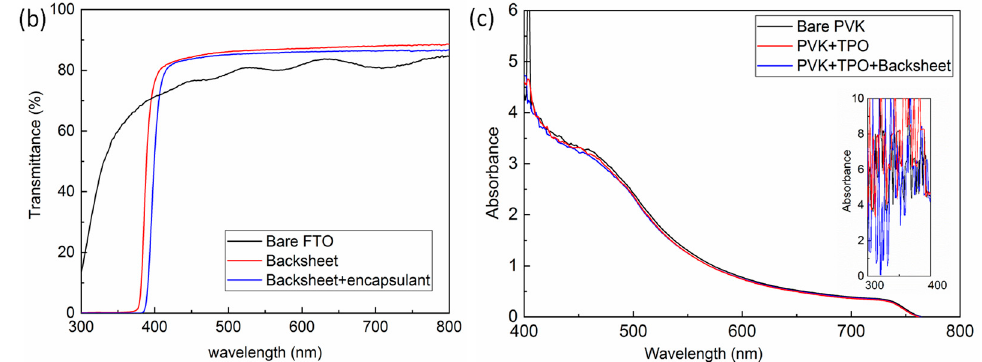
Figure 2. ( a ) J-V curve of the PSCs before and after encapsulation with different materials. ( b ) The transmittance of FTO, backsheet, and backsheet overlay with encapsulant. ( c ) Absorption spectra of bare perovskite film, perovskite films/laminated TPO, and perovskite/laminated TPO/backsheet.